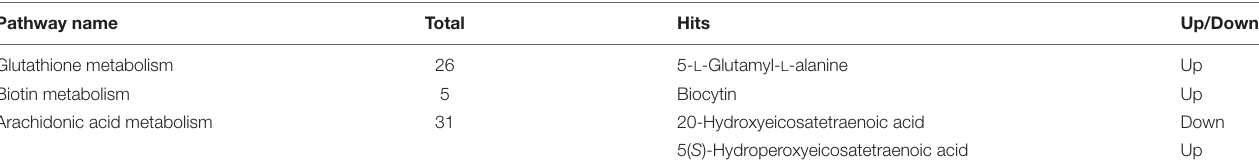
TABLE 5 | The most relevant metabolic pathways and corresponding differential metabolites in the liver of juvenile American eels of the HIS group in comparison with the control group.